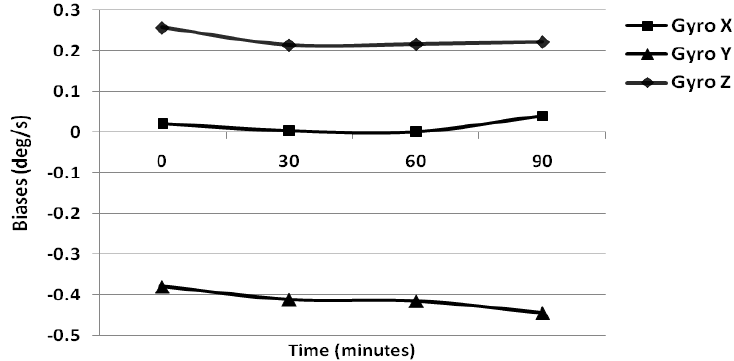
Figure 2. Gyroscope in-run biases (const.